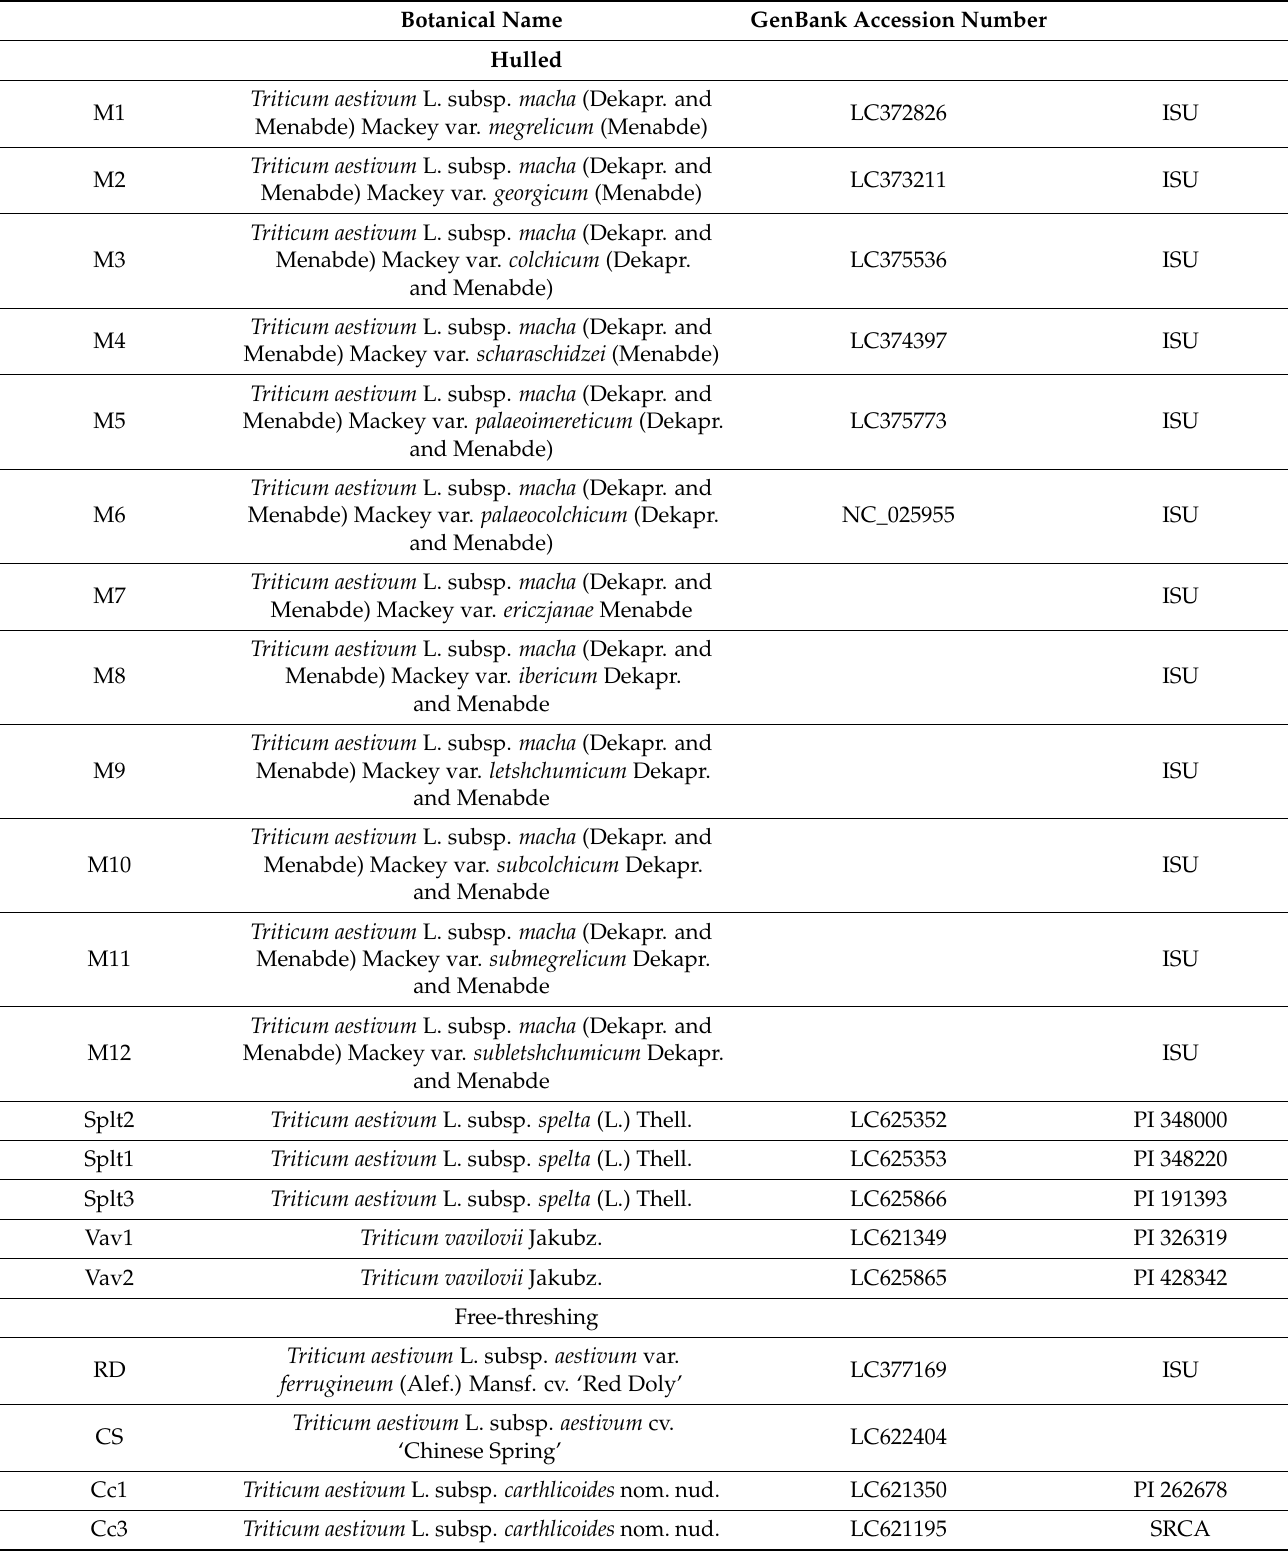
Table 3. Hexaploid wheat accessions used in the